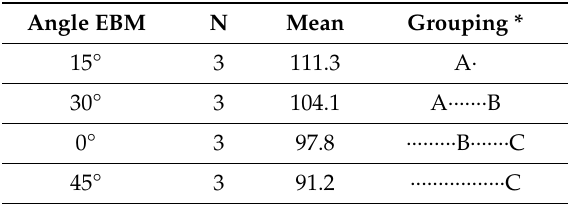
Table 4. Grouping information using the Tukey method and 95% confidence interval on the CA measurements of the EBM